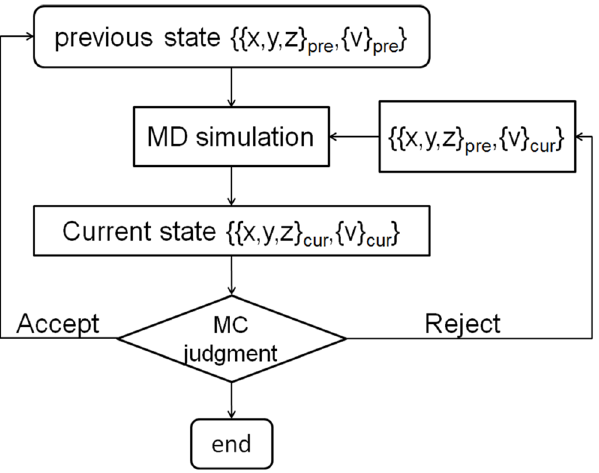
Fig 2. The illustration of MD-MC iterations in the hybrid